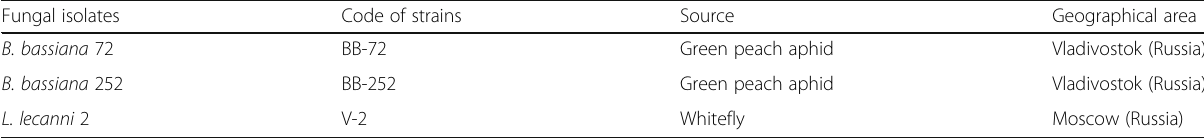
Table 1 Studied fungal isolates, code of strain, source, and geographical area of Beauveria bassiana and Lecanicillium lecanii strains Fungal isolates Code of strains